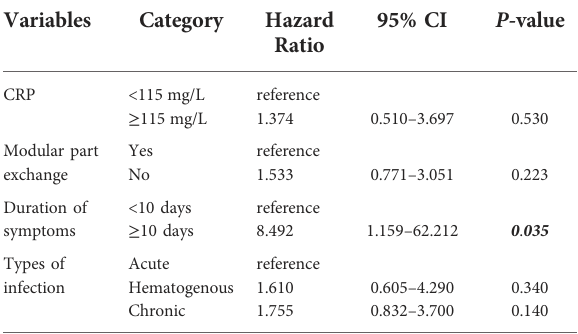
TABLE 3 Multivariable analysis for treatment failure following DAIR for PJI